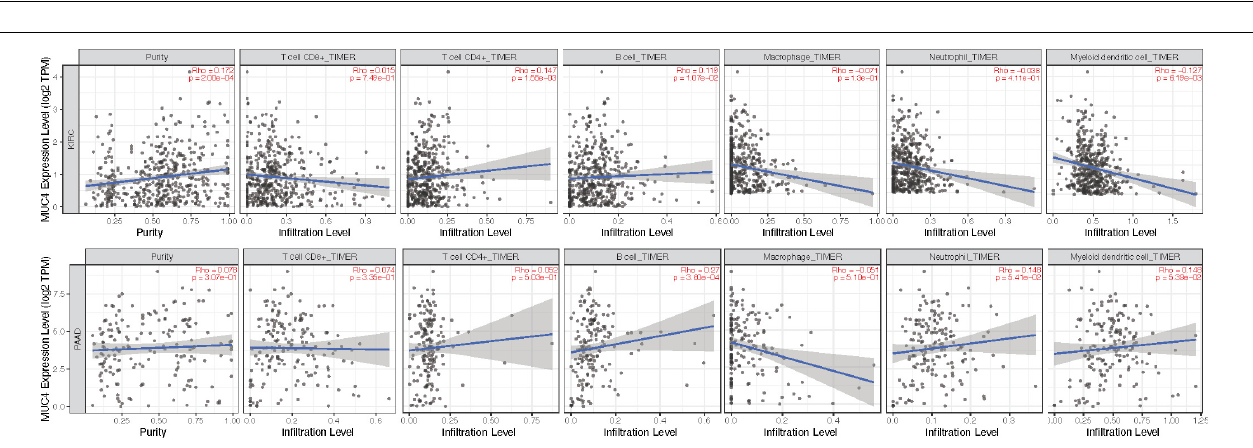
(score = 0.979), MUC7 (score = 0.978), MUC15 (score = 0.971), MUC21 (score = 0.964), GRLANT6 (score = 0.957),